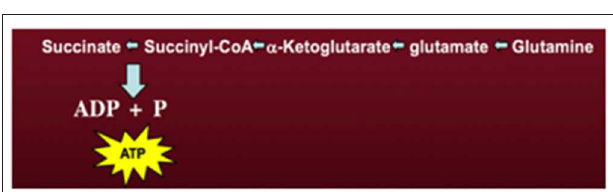
FIGURE 2 | The glutaminolysis pathway. The succinyl-CoA ligase reaction, metabolizing succinyl-CoA to succinate, produces high-energy phosphates (ATP) in the absence of oxidative phosphorylation through the process of substrate-level phosphorylation in the mitochondrial matrix. Provision of succinyl-CoA by the α -ketoglutarate dehydrogenase complex is crucial for maintaining the function of succinyl-CoA ligase thus preventing the adenine nucleotide translocase from reversing. Succinate contributes to inflammation and stabilizes Hif-1a, a key transcription factor that contributes to the aerobic fermentation